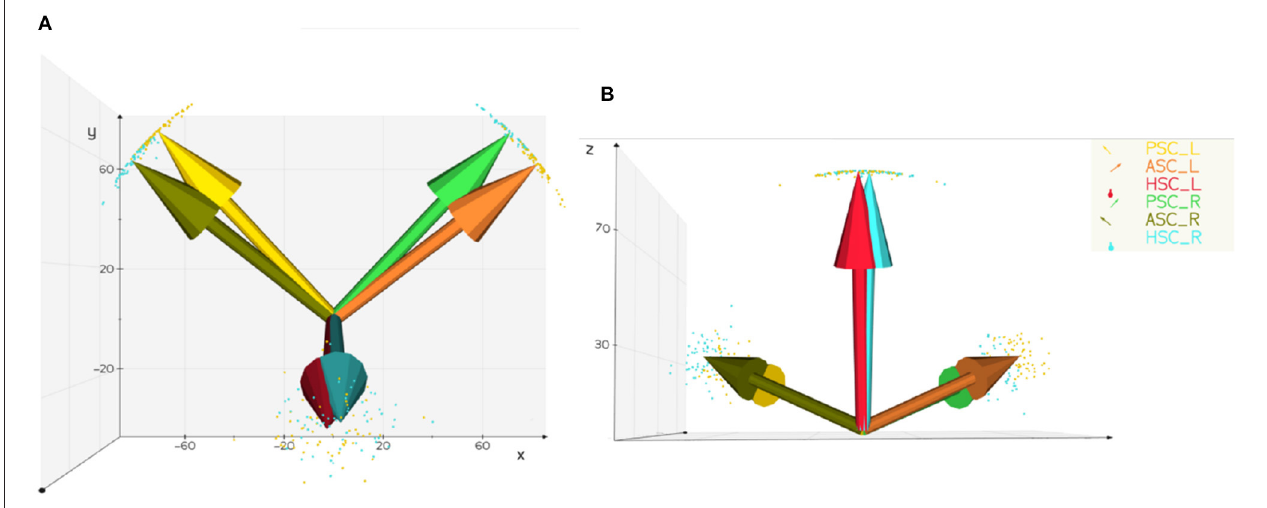
FIGURE 5 | Distribution and average normal vector of the semicircular canal plane. PSC, posterior semicircular canal; ASC, superior semicircular canal; HSC, lateral semicircular canal; R, right; L, left. (A) Vertical view scatter points represent the unit normal vector and arrows represent the average normal vector (B) back view the plane normal vectors of the left and right lateral semicircular canals are nearly parallel, and the plane normal vectors of the posterior semicircular canals and the contralateral superior semicircular canals have only a small intersection angle.